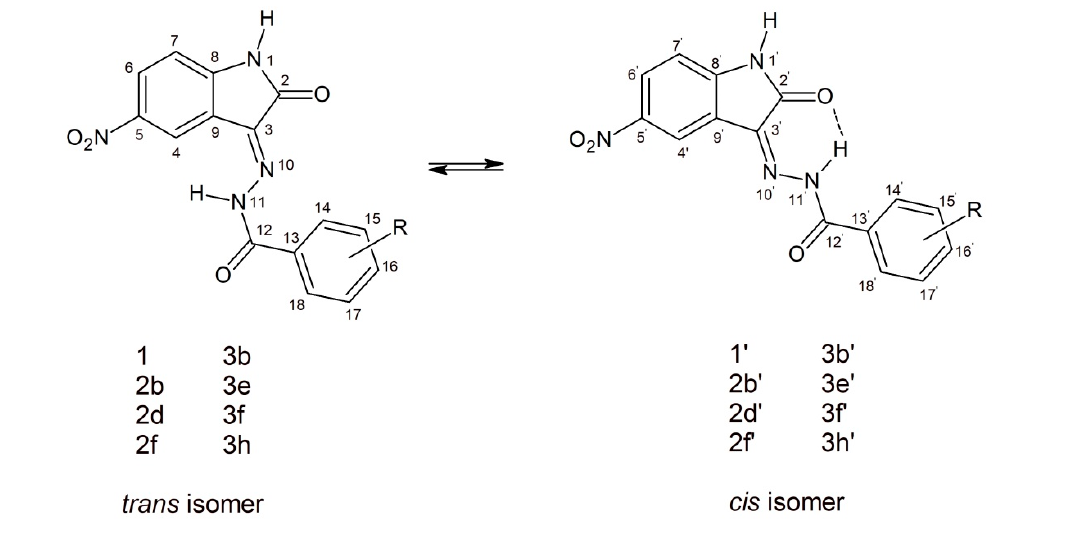
Figure 6. Possible geometry of the synthesized 5-nitroisatin-based benzoylhydrazines.